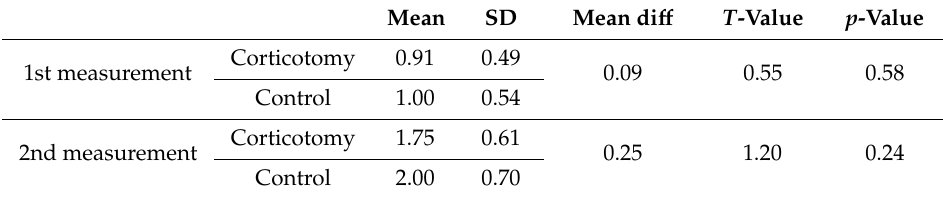
Table 2. Comparison of the molar anchorage loss of the upper first molars in the partial corticotomy side and the control side (to the nearest 0.1 mm).